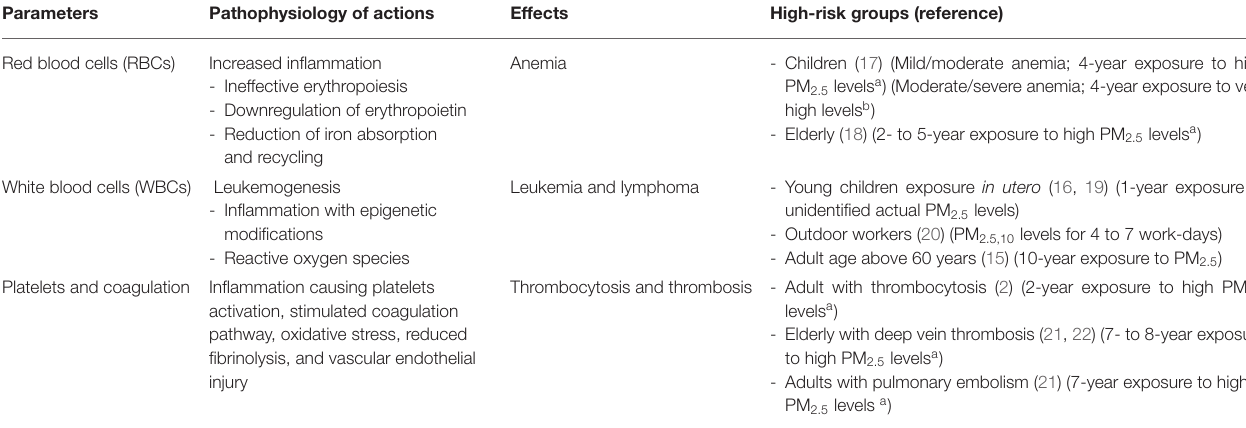
TABLE 2 | Pathophysiology of PM 2.5 effects on individual hematologic parameters and the high-risk groups.